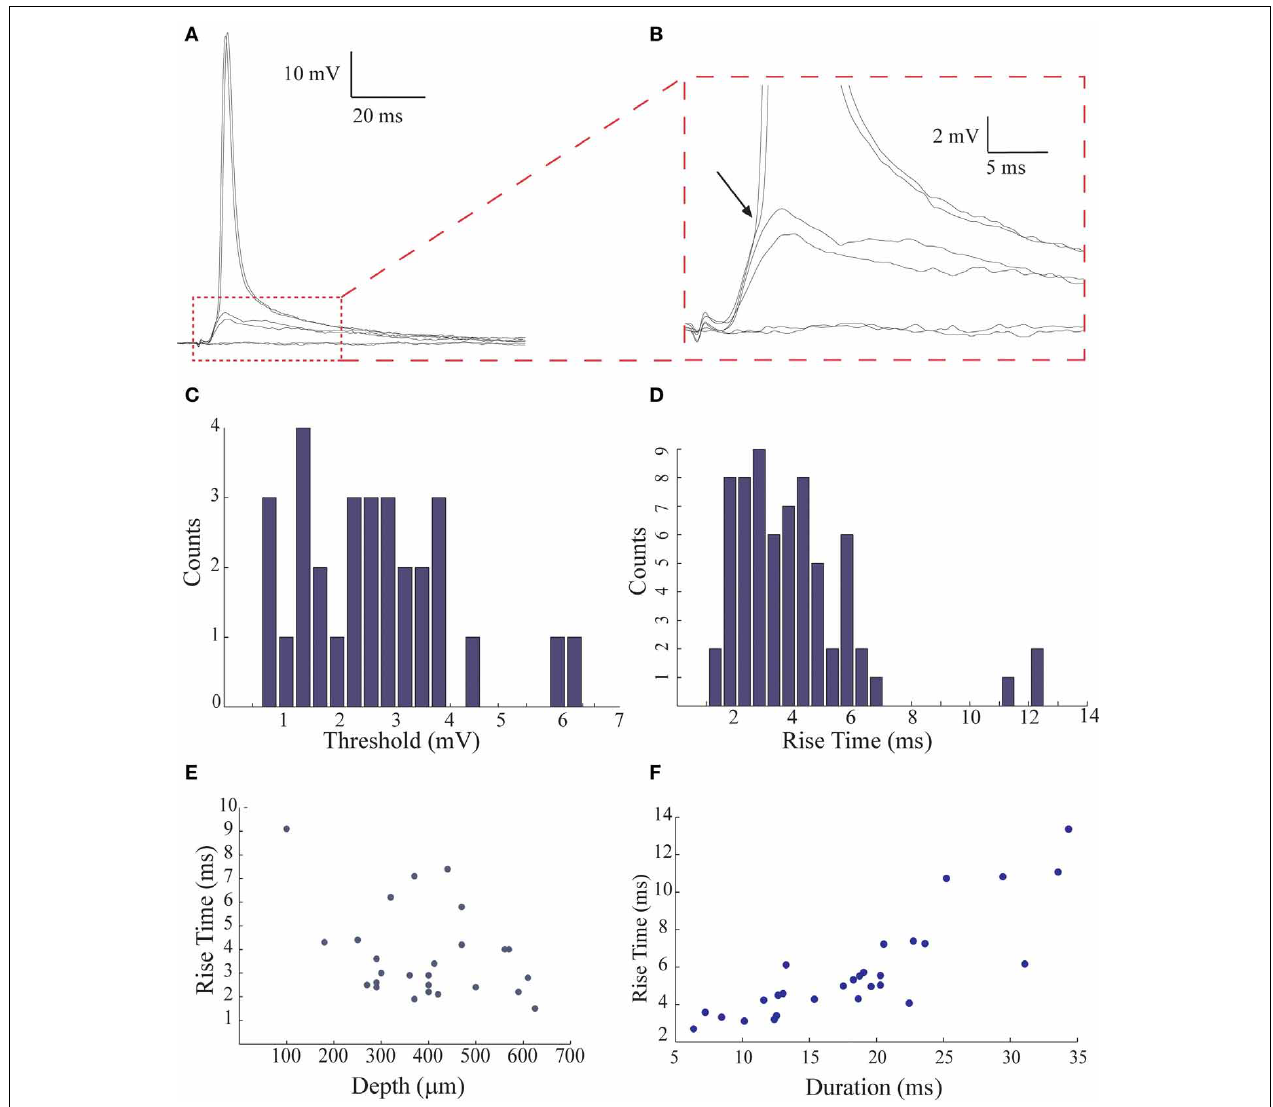
FIGURE 3 | The low threshold for spike initiation and the fast rise time of the post synaptic responses evoked by afferent nerve stimulation. (A,B) Sub- and suprathreshold responses evoked by afferent nerve stimulation displayed at different scales. Arrow in (B) indicates the deflection points in the voltage trace that correspond to the threshold. (C) The distribution of the threshold level for spike